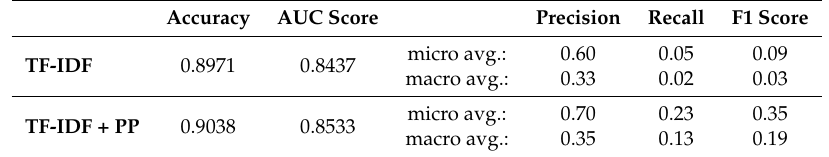
Table 7. Performance of the composed BiLSTM + CNN model with TF-IDF text documents representation.